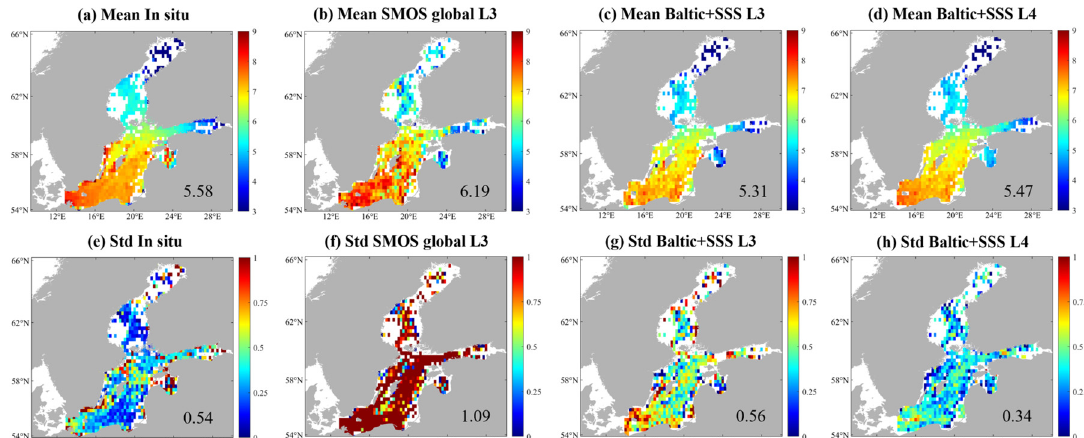
Figure 3. Mean SSS field in the Baltic Sea averaged from collocated ( a ) multi-source in situ salinity measurements. ( b ) BEC global L3 product, ( c ) Baltic+SSS L3 product and ( d ) Baltic+SSS L4 product on a consistent 0.25°×0.25° grid. The lower panels show the corresponding STD values of the collocated ( e ) multi-source in situ SSS measurements and ( f ) BEC global L3 product, ( g ) Baltic+SSS L3 product and ( h ) Baltic+SSS L4 product. The numbers labeled in the lowest right are the spatial average SSS values. The unit is in PSU.